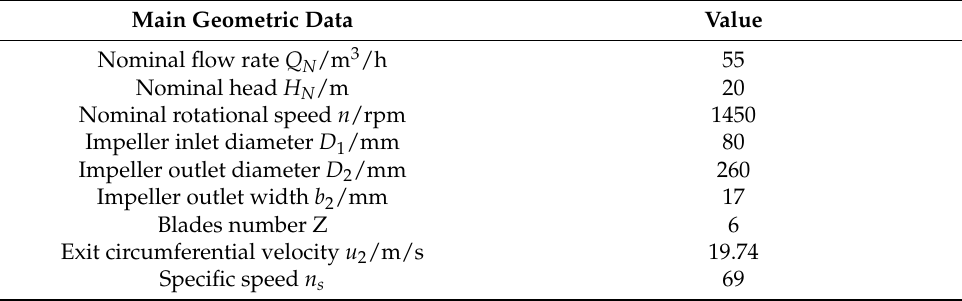
Table 1. Design parameters of the tested pump.